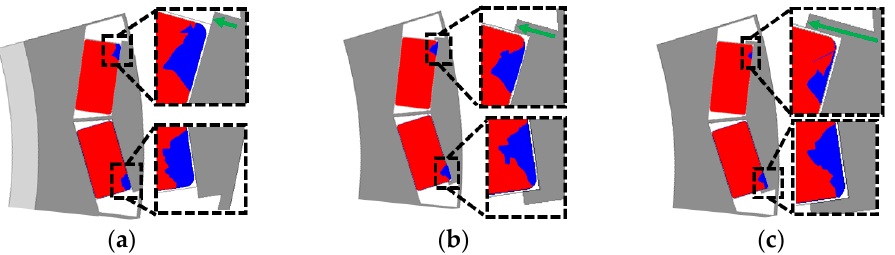
Figure 12. Irreversible demagnetization area according to different lengths of steel plate inserted in the barrier: ( a ) 0 mm, ( b ) 0.6 mm, ( c ) 1.2 mm.